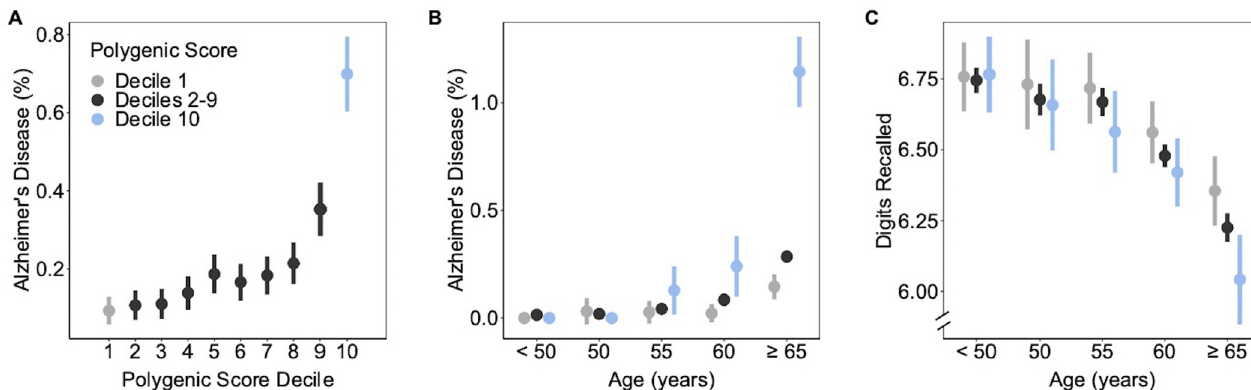
Fig 2. Association of a polygenic score for Alzheimer’s disease with clinical diagnosis and cognitive function. a . Relationship of polygenic score decile to rates of Alzheimer’s disease diagnosis within the UK Biobank testing dataset. b . Age-stratified analysis of the relationship between polygenic score decile groupings and Alzheimer’s disease diagnosis within the UK Biobank testing dataset. Age is assigned based on age at diagnosis of Alzheimer’s disease for those affected or date of last follow-up for others. c. Age-stratified analysis of the relationship between polygenic score decile groupings and performance on a ‘digit recall test,’ a measure of cognitive function. Age is binned into groups corresponding to < 50, � 50–54, � 55–59, � 60–64, and � 65 years at time of assessment. Error bars represent 95% confidence